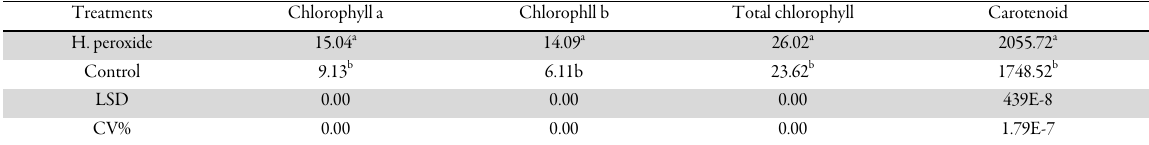
Table 3. Exogenous application of hydrogen peroxide on the photosynthetic pigment accumulation of cowpea